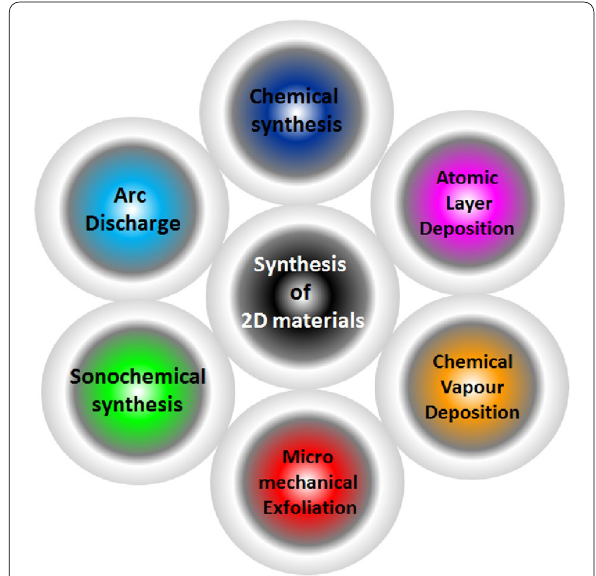
Fig. 2 Methods of synthesis of 2D materials